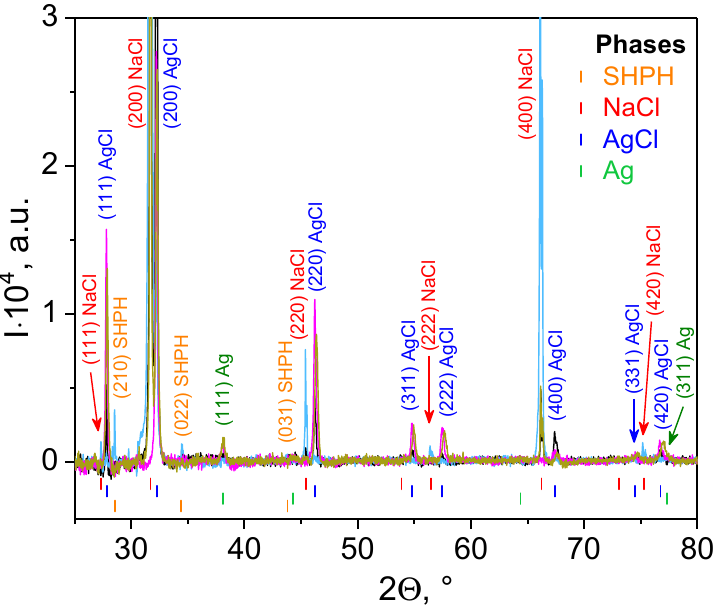
Figure 4. XRD patterns for samples with silver-based nanoparticles phyto-generated from turmeric: Tur-nAg/AgCl (black line), Tur-nAg/AgCl–Lip (light blue line), Tur-nAg/AgCl–CTS (magenta line), and Tur-nAg/AgCl–Lip–CTS (dark yellow line). Table 1. Structural parameters derived from the analysis of SAXS and XRD data of the silver/silver chloride nanoparticles for biohybrid complexes. The D XRD is the average crystallite size and D SAXS, i = 2(5/3) 1/2 R g, i is an average diameter of Tur- nAg/AgCl.